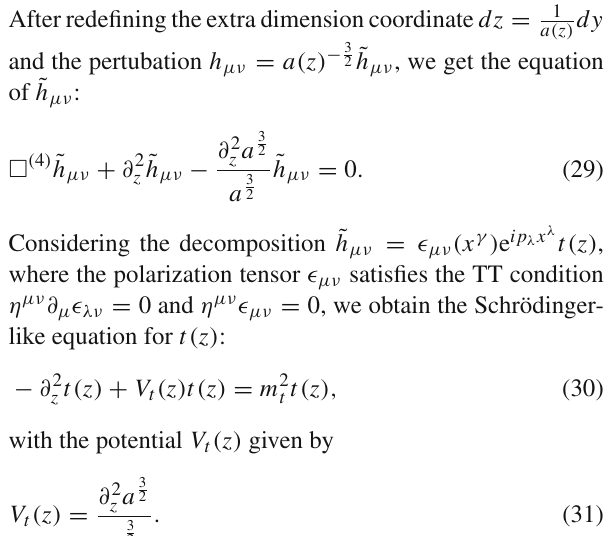
Fig. 5 a a = 0 . 2, b b = 0 . 8, c b = 2 . 5 The effective potential V t ( z ) (blue solid lines) and the zero mode t 0 ( z ) (red dashed lines) of the tensor perturbation for brane model 3. The parameters are set k = 1, and a = 0 . 2 in a , b = 0 . 8 in b , b = 2 . 5 in